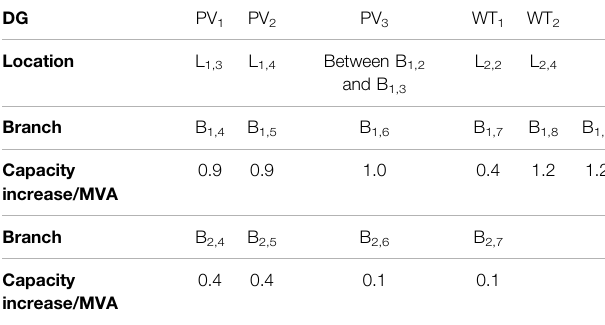
TABLE 5 | DG location and feeder capacity improvement measures. DG PV 1 PV 2 PV 3 WT 1 WT